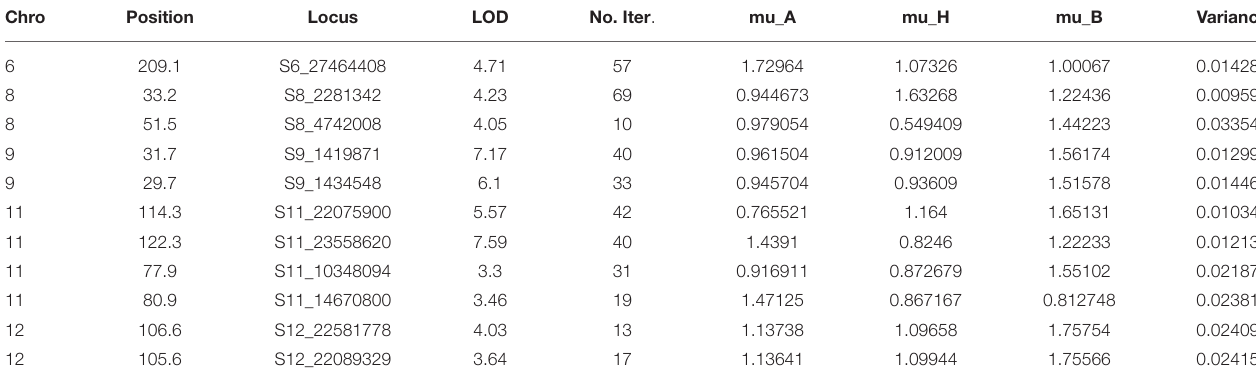
TABLE 3 | Fruit firmness QTL identified using MQM mapping in a biparental cross. Chro Variance